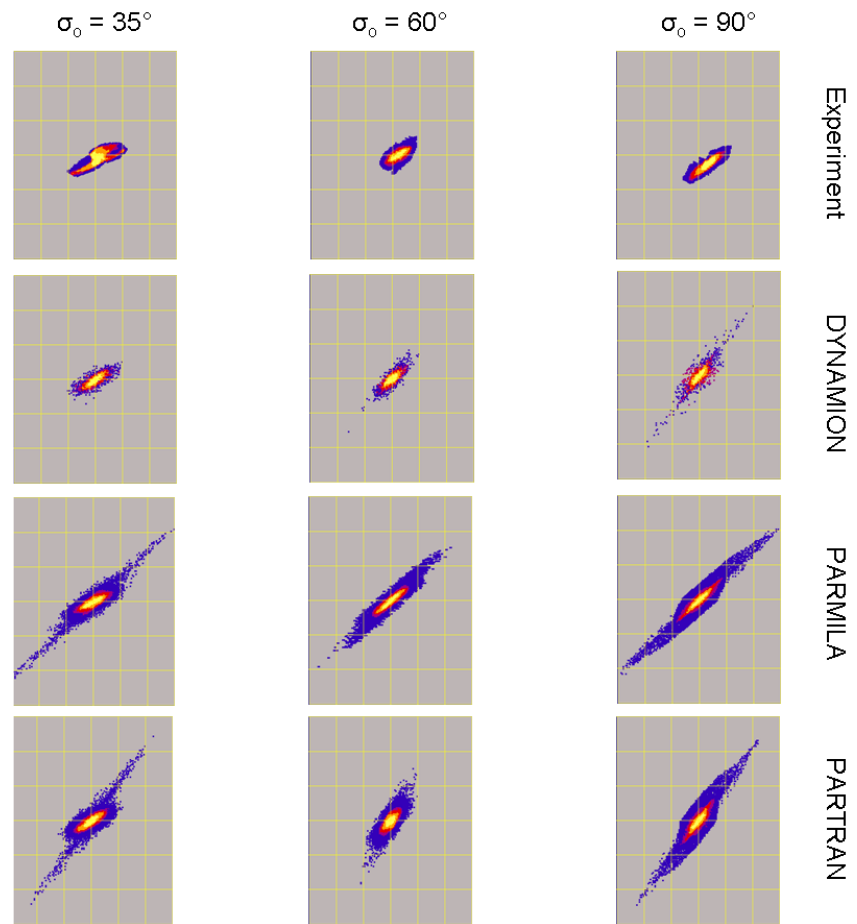
FIG. 12. (Color) From top to bottom: vertical phase space distributions as measured and simulated at the exit of the DTL using DYNAMION , PARMILA , and PARTRAN . Left: (cid:4) o ¼ 35 (cid:4) 30 mrad (vertical axis),